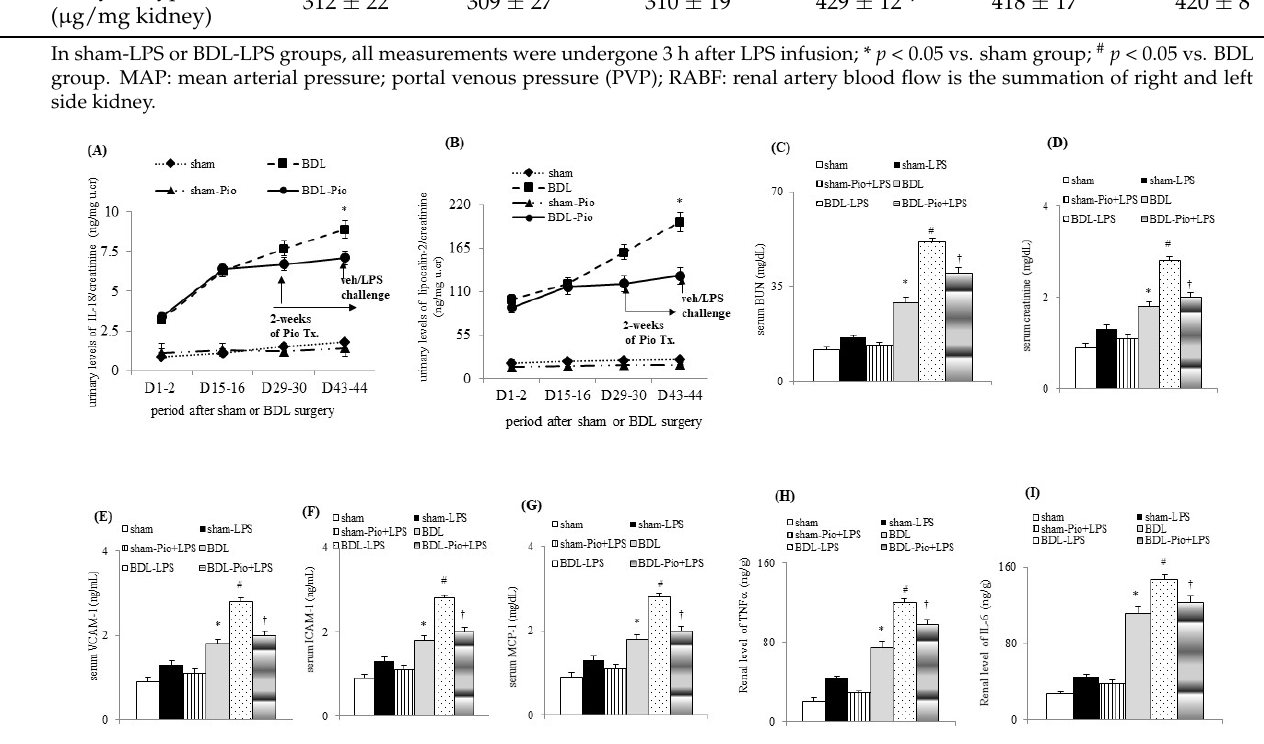
Figure 2. Chronic pioglitazone treatment suppressed LPS ‐ induced acute on chronic renal dysfunction by prevention of increased renal macrophage infiltration. ( A ) Renal interleukin ‐ 18 (IL ‐ 18) expression; ( B ) various renal protein expressions